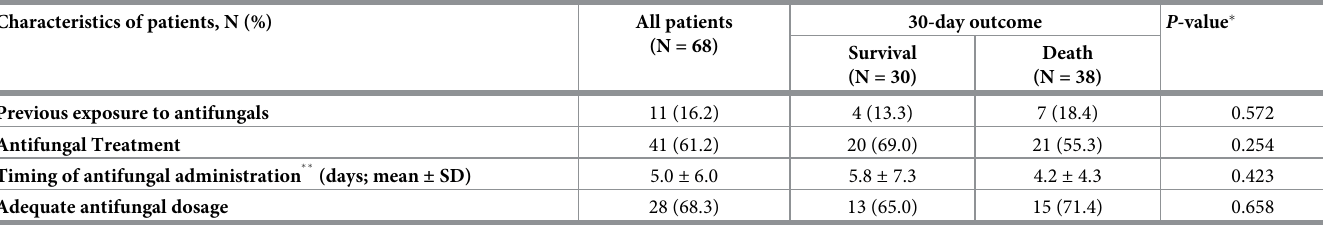
Table 4. Antifungal stewardship in patients with candidemia, including comparison between subgroups according to the outcome. Characteristics of patients, N (%)